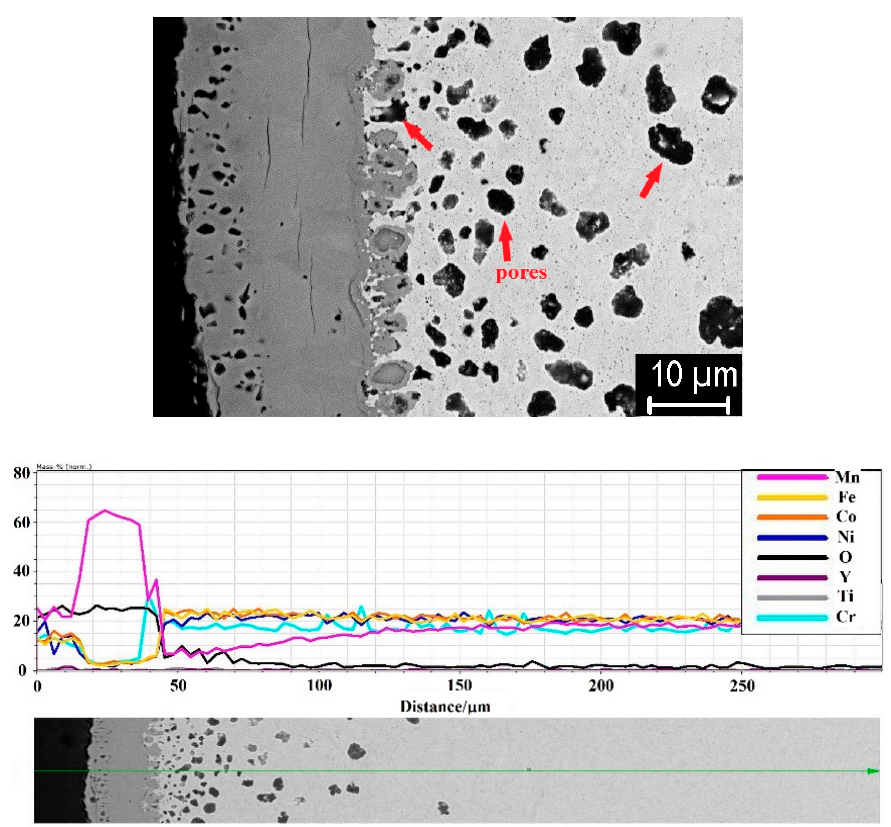
Figure 5. SEM images (backscatter mode) of the oxide scales coupled with plots of elemental distribution in the oxide scale and the adjacent alloy region measured by GDOES. The actual concentration of the element is multiplied by the factor described in the legend. The results refer to 150 h of oxidation at 750 °C.